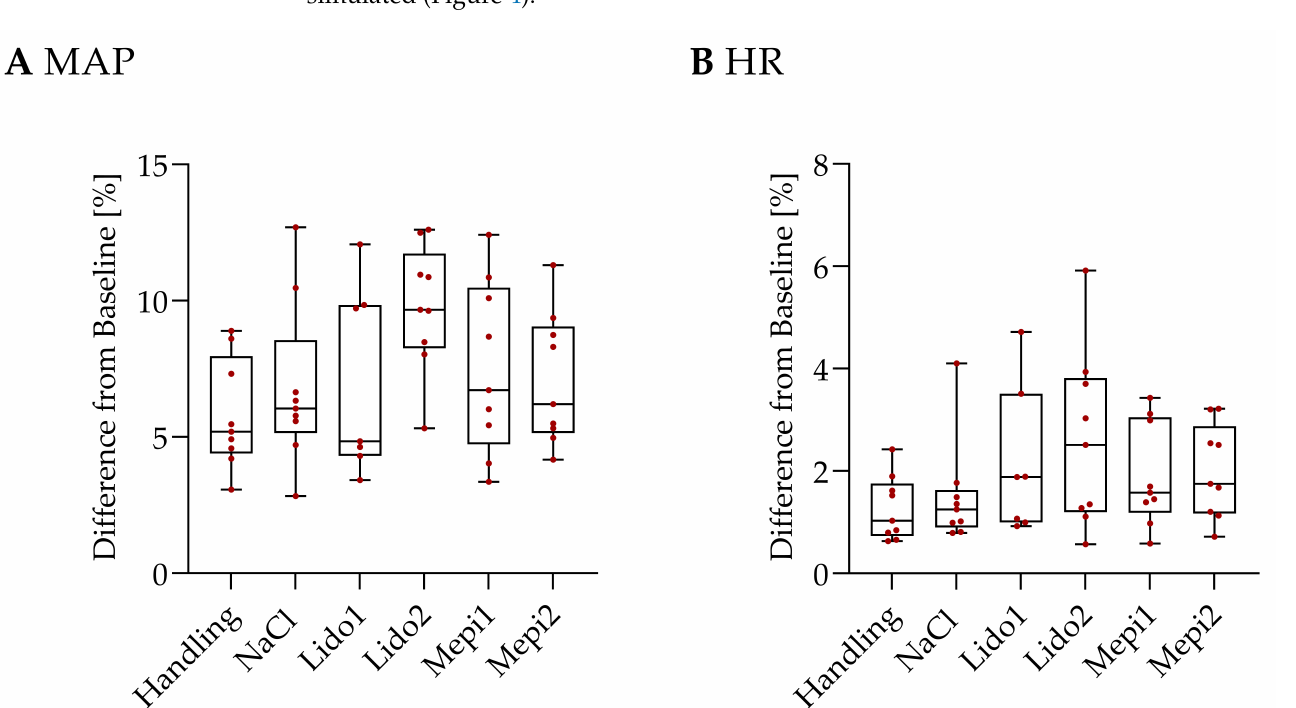
Figure 4. Injection. Percent change in MAP ( A ) and HR ( B ) during injection. Values shown are means ±